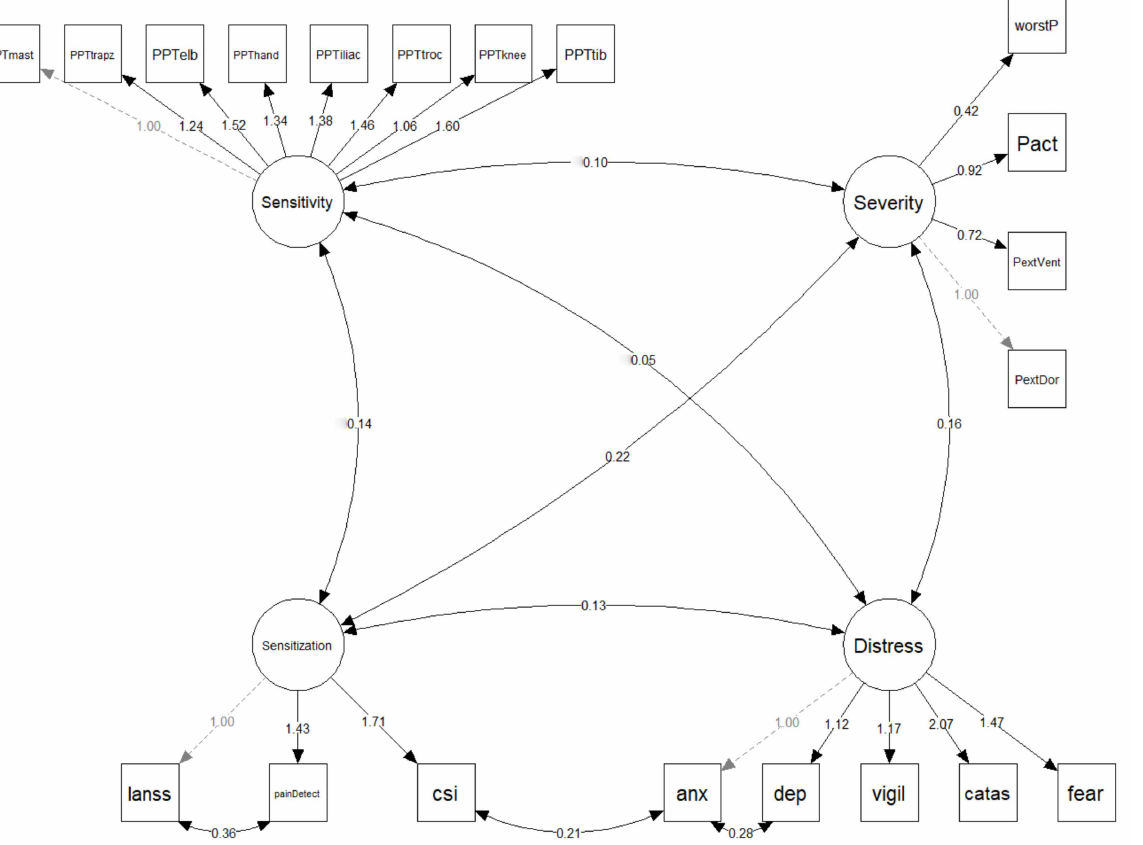
Figure 1. Theoretical latent variable model. Variables surrounded by a square box are observed variables, whilst those in a circle are latent variables. Numbers reflect standardized parameter estimates. Dotted arrows reflect fixed relationships. PPT: pressure pain threshold; mast: mastoid process; trapz: upper trapezius; elb: elbow; iliac: posterosuperior iliac spine; troc: greater trochanter; tib: tibialis anterior; worstP: worst pain at rest; Pact: pain during daily activities; PextVent: pain extent ventral surface; PextDor: pain extent dorsal surface; S-LANSS: self-reported Leeds Assessment of Neuropathic Symptoms and Signs; csi: Central Sensitization Inventory; anx: anxiety (HADS-A); dep: depression (HADS-D); vigil: Pain Vigilance and Awareness Questionnaire (PVAQ); catas: Pain Catastrophizing Scale (PCS); fear: Tampa Scale for Kinesiophobia